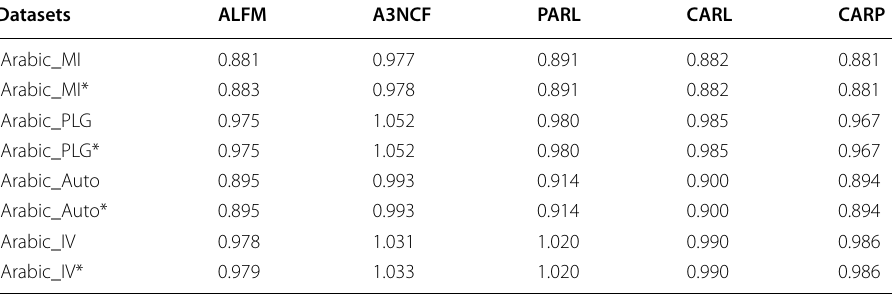
Table 3 Impact of the preprocessing phase on RSs in the Arabic context